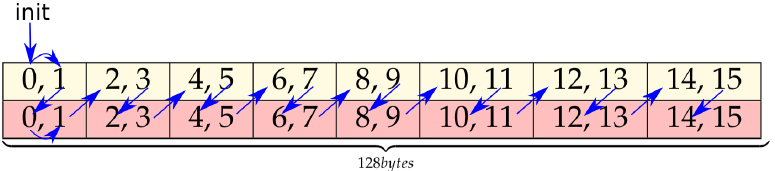
Figure 9. Data reading order from shared memory to registers.